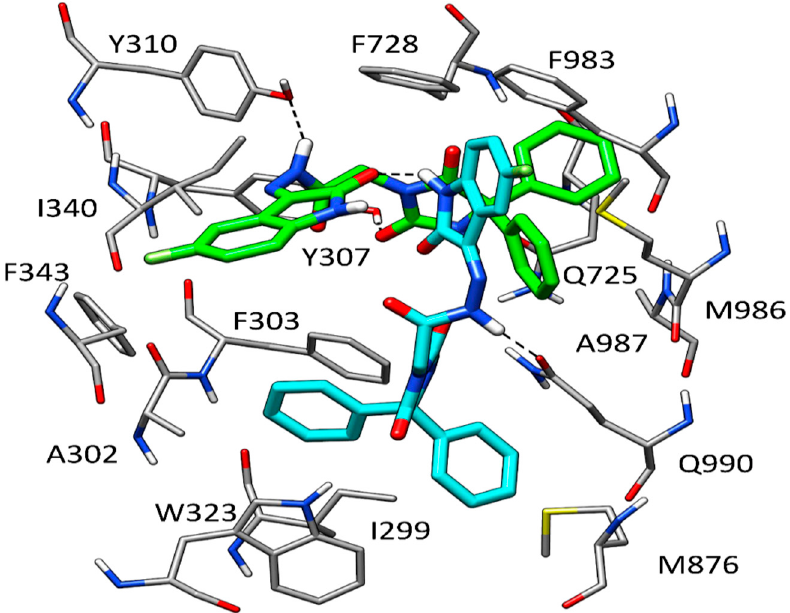
Figure 4. Binding mode predicted for two molecules of HAA 2021 within P-gp.